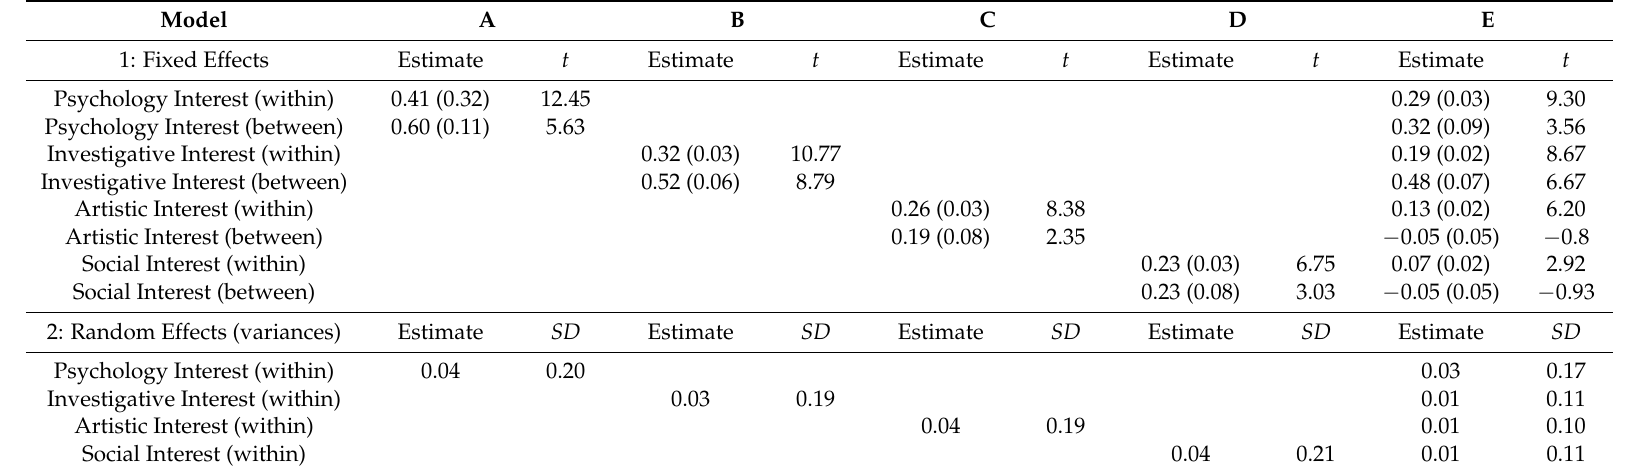
Table 3. Parameter estimates for multilevel models of openness as a function of